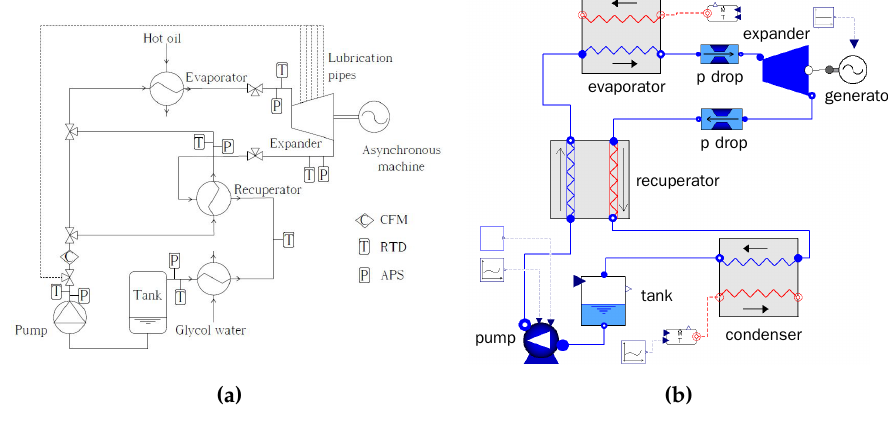
Figure 3. Process flow diagram of the ORC with the sensors’ position ( a ) and the ORC system model from the Modelica-Dymola GUI ( b ). CFM, Coriolis flow meter; RTD, resistance temperature detector; APS, absolute pressure